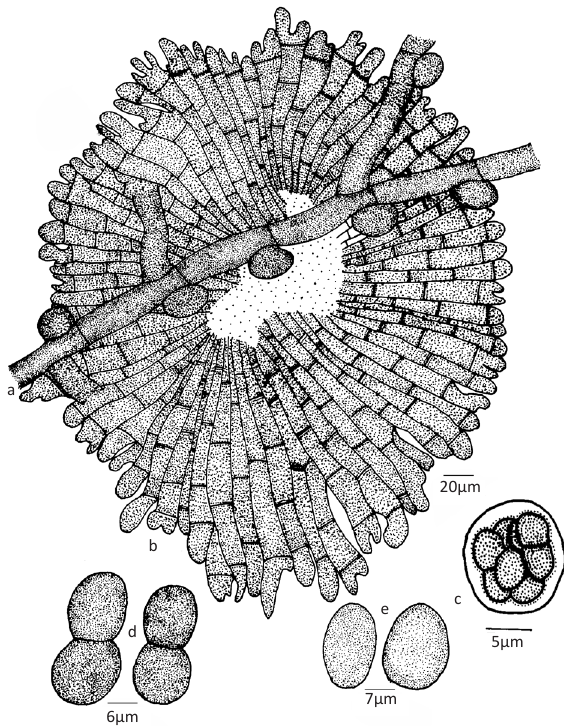
Figure 3. Asterina chrysophylligena sp. nov. a - Appressoriate mycelium; b - Thyriothecium; c - Ascus; d -